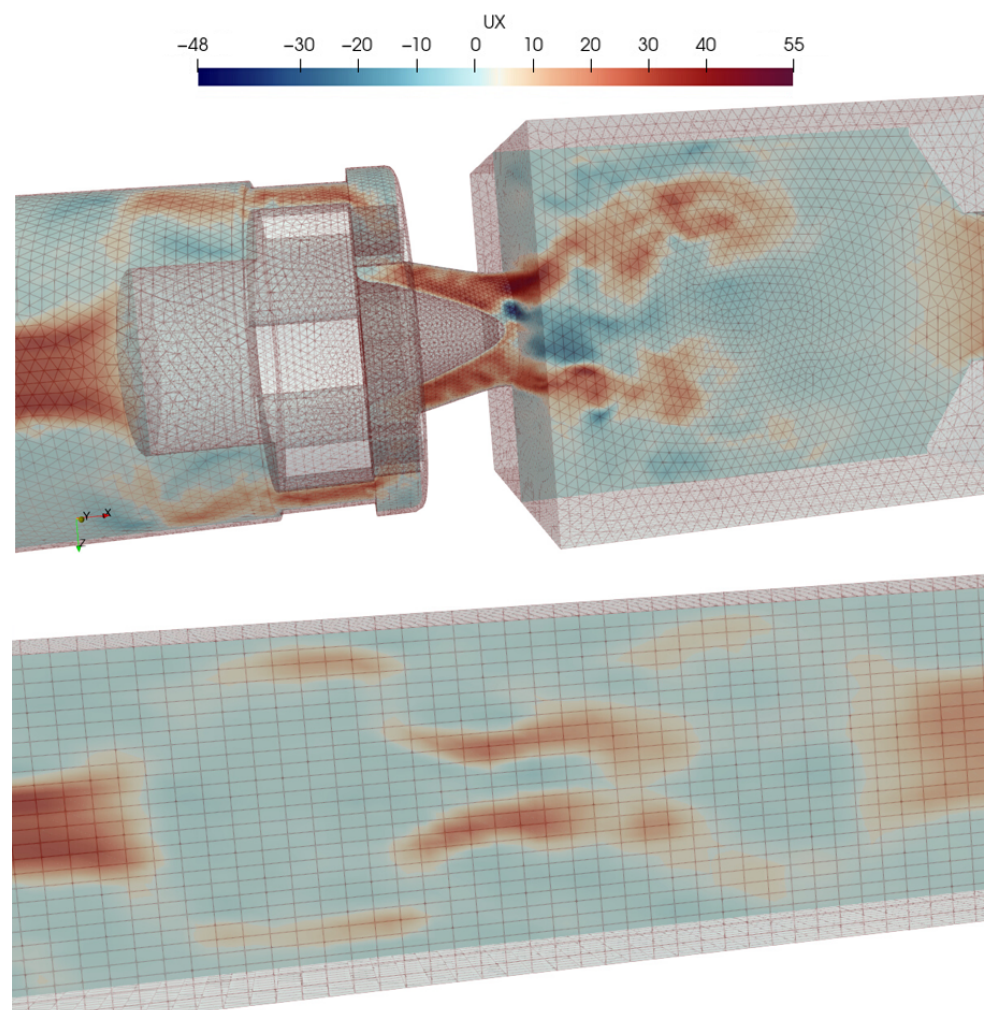
Figure 25. On the top, a 2D plane of the high-fidelity horizontal velocity field in m/s by the solver Yales2 at 0.005 s. On the bottom, a 2D plane of the horizontal velocity field in m/s by the mean prediction of the Bayesian nonlinear ROM at 0.005